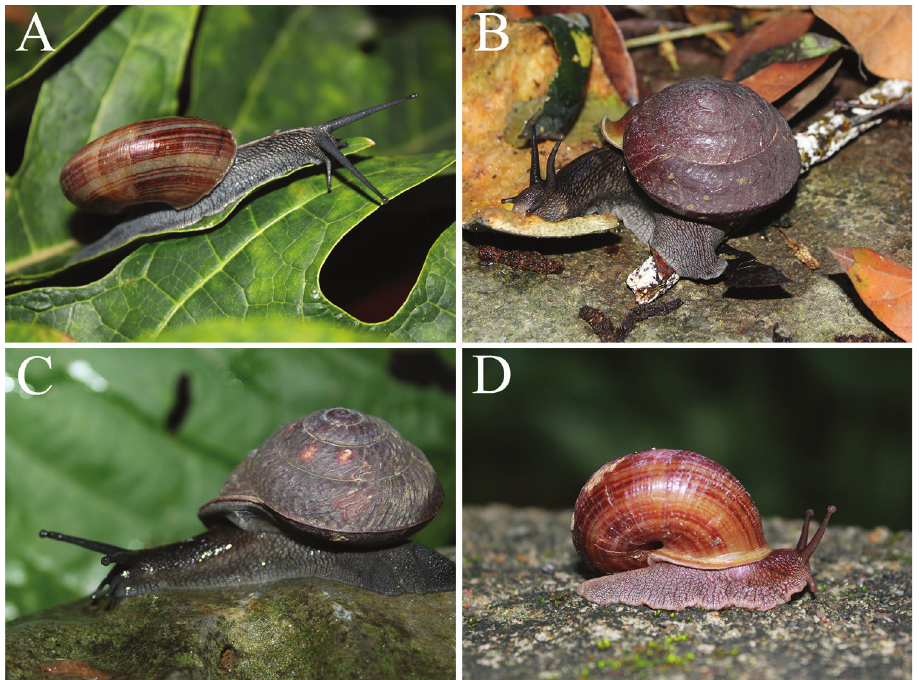
Figure 5. Ecological photographs of snails. A Camaena lingyunensis sp. n. (Kasuo, Lingyun, Guangxi, China) B Camaena detianensis sp. n. (Detian Falls, Daxin, Guangxi, China) C Camaena hahni (Huu Lien Nature Reserve, Lang-Son, Vietnam) D Camaena cicatricosa (Yangchun, Guangdong,